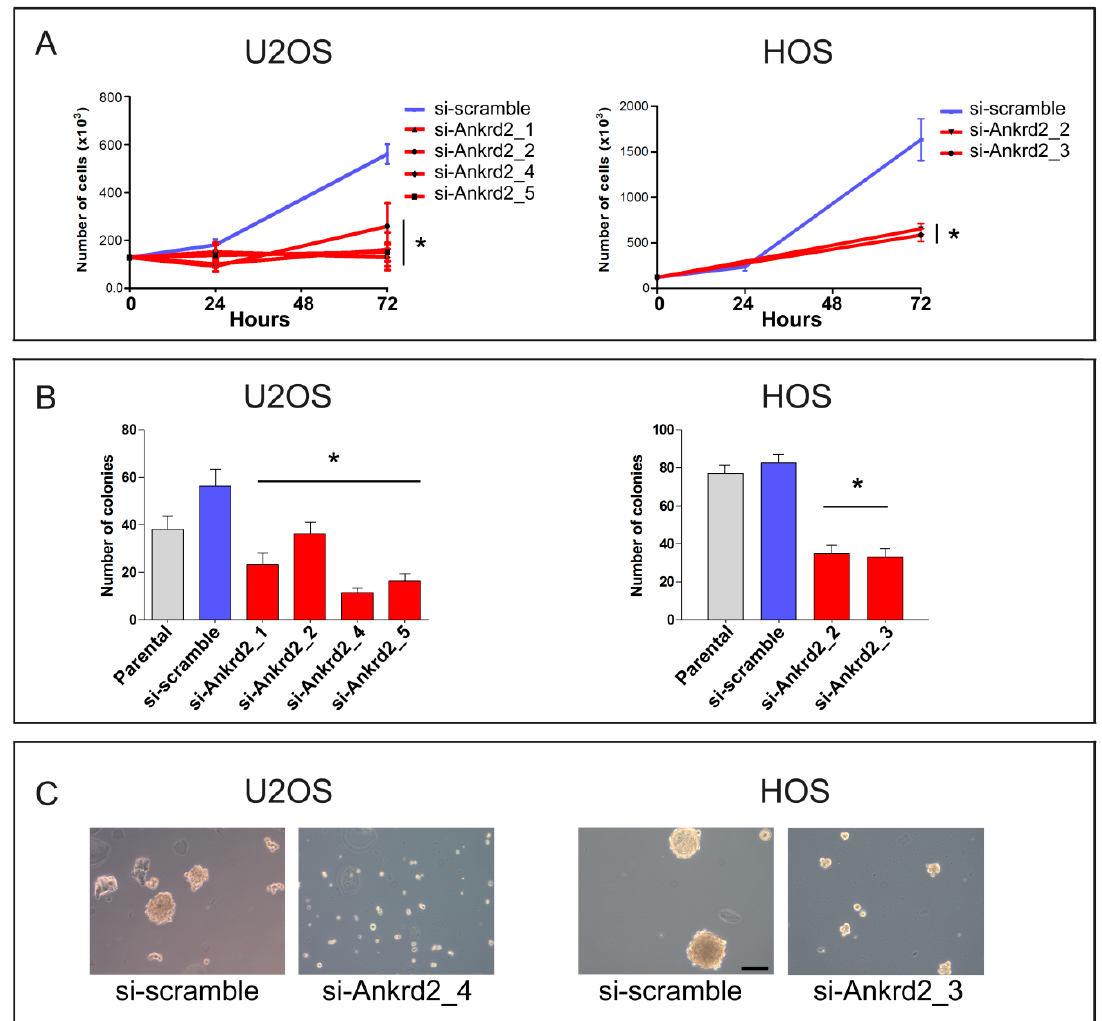
Figure 7. Silencing of Ankrd2 expression reduces proliferation and clonogenic potential of U2OS and HOS cells. ( A ) Stable clones of Ankrd2-silenced U2OS and HOS cells were seeded at a density of 2 × 10 5 cells/well in six-well tissue culture plates. Then, 24, 48 and 72 h after seeding, cells were individually collected and counted under light microscope. As control, the proliferation rate of respective parental and si-scramble cells was also determined. * p < 0.01, vs. si-scramble. Data are representative of a minimum of three independent experiments. Data were analyzed and graphed using the GraphPad Prism software, San Diego, CA, USA. ( B ) The same clones as in ( A ) were plated at a density of 13.3 cells/cm 2 and allowed to grow for two weeks. Colonies with >50 cells were counted and the results were graphed using the GraphPad Prism software. Statistical analysis was performed using an unpaired two-tail Student’s t -test. * p < 0.01 vs. si-scramble. ( C ) Control (si-scramble) and Ankrd2 silenced clones were seeded at a density of 2 × 10 5 cells/35 cm 2 culture dish in complete media containing methyl-cellulose on a 8% layer of 0.8% agar and allowed to grow. Spheroids were observed by light microscopy. Images of U2OS (clone 4, si-Ankrd2_4) and HOS (clone 3, si-Ankrd2_3) unable to form spheroids when partially depleted of Ankrd2 are shown. The bar is 100 µ